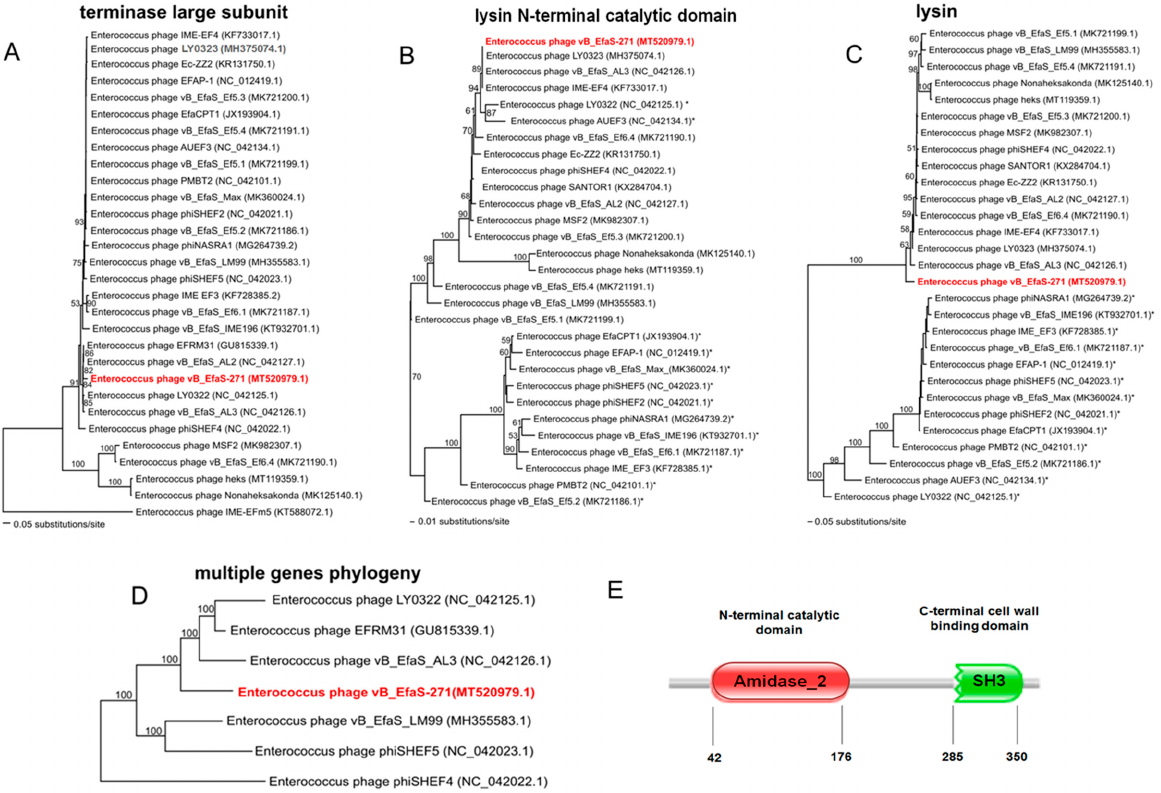
Figure 4. Neighbour-joining phylogenetic trees showing the phylogenetic position of vB_EfaS_271 phage (in red color) across other Enterococcus phages. Trees were constructed using PAUP * and based on: the sequence coding for terminase large subunit TerL ( A ), fragment of the lysin gene including sequence coding for an N-terminal catalytic domain of this protein ( B ) the complete sequence of the lysin gene ( C ), and sequences of 26 genes listed in the Supplementary Table S5 and coding for proteins of known functions ( D ). The reference sequences of the tested genes were collected from NCBI database. Bootstrap values > 50% calculated on the basis of 1000 resamplings are shown at the nodes. Branch lengths represented by a scale bar indicate the number of substitutions per site. Panel ( E ) shows domain organization of the lysin protein of the vB_EfaS_271 phage. The prediction was done with the Pfam database [61] (European Molecular Biology Laboratory, ELIXIR, Pram 33.1). Available online: http: // pfam.xfam.org / (accessed on 26 August 2020). Specific protein domains: N-acetylmuramoyl-L-alanine amidase (Amidase 2) and SH3 domain are marked with red and green colors, respectively. Numbers indicate positions of amino acids representing the beginning and end of the domain